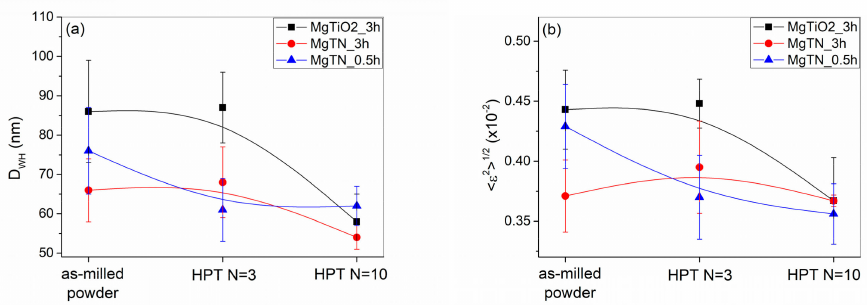
Figure 4. Average crystallite size D WH ( a ) and square root of the mean square strain (cid:104) ε 2 (cid:105) 1 / 2 ( b ) of the hexagonal Mg phase for the as-milled powders and HPT-disks obtained by the Williamson–Hall method.